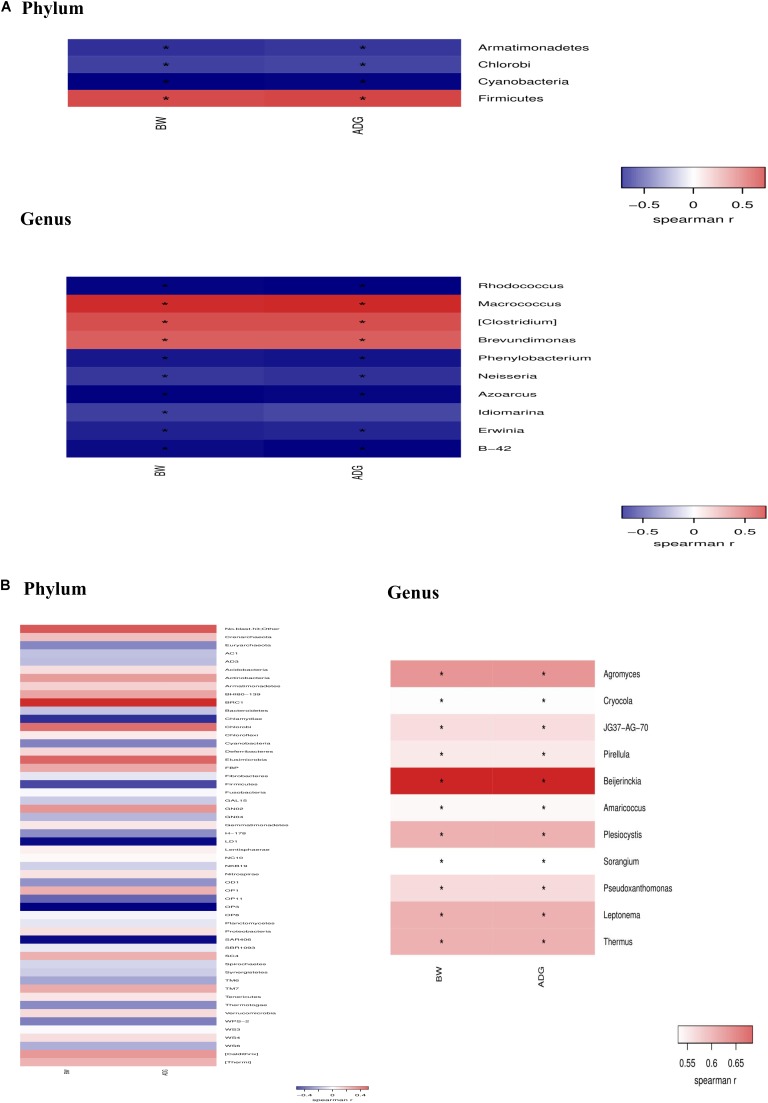
Spearman’s rank correlation coefficient between taxonomic change of jejunal microflora because of dietary Bacillus spp. supplementation and growth performance (BW and ADG) on day 21 (A) and day 42 (B).